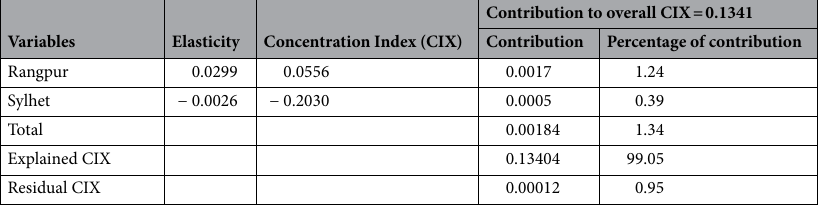
Table 3. Decomposition of the concentration index obtained with respect to educational status.